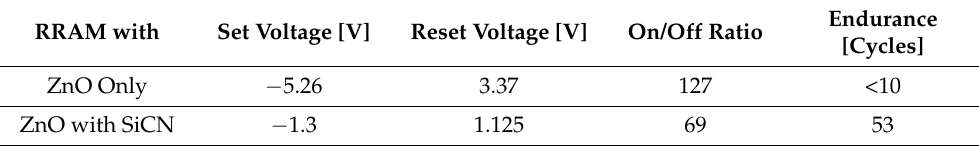
Table 2. ZnO RRAM characteristics with and without the SiCN film as an oxygen reservoir. RRAM with Set Voltage